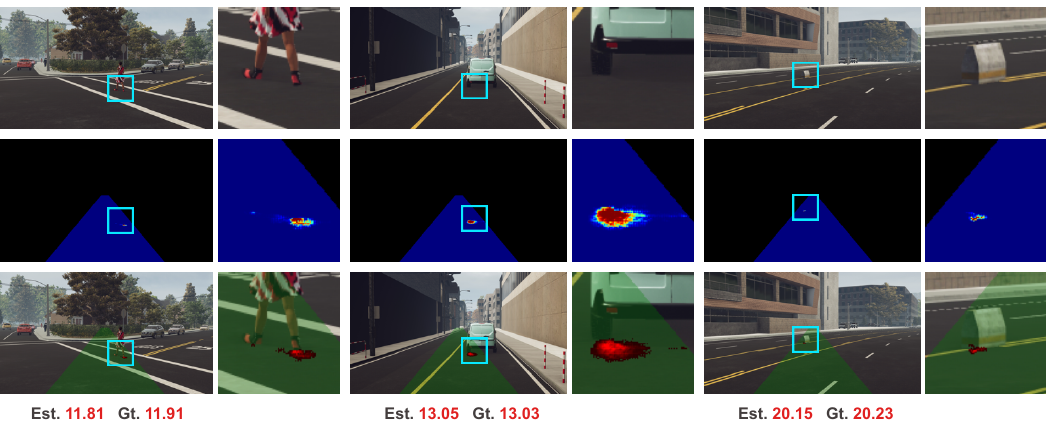
Figure 5. Visualization of generated weight maps. The first row is the color image. The second row is the colorized weighted map. The last row is the color image superimposed on the preset collision region and the colorized weighted map. This interpretable representation of the last row will be used to illustrate experimental results in the following. We use cyan rectangles to highlight the notable regions and zoom in these regions for better